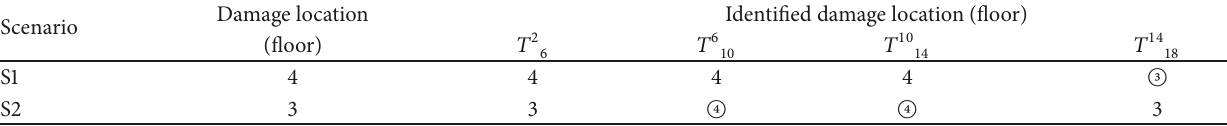
Table 10: Identified damage locations based on WPEV and SVM.